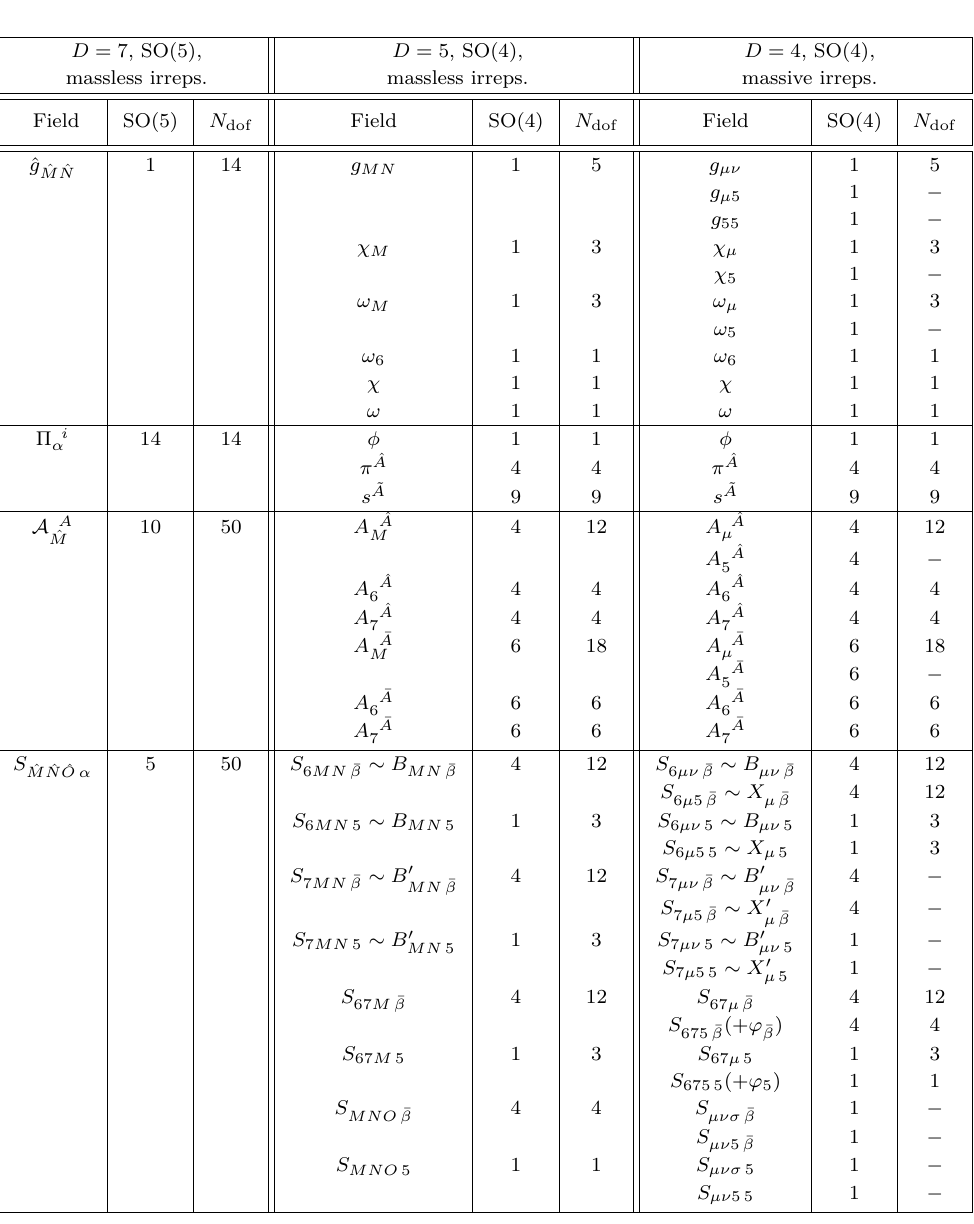
Table 1 . The field content of the model, organised in terms of the irreducible representations of the symmetries in D = 7 dimensions ( SO(5) multiplets), as well as D = 5 and D = 4 dimensions ( SO(4) multiplets). In the case of the language in D = 4 dimensions, we indicate the field content in terms of the massive representations of the Poincaré group, and keep into account the gauge-invariant combinations only. The irreducible representations for which we indicate N where either the degrees of freedom combine into gauge invariant combinations with other fields, or have already been included due to the self-duality of the 3